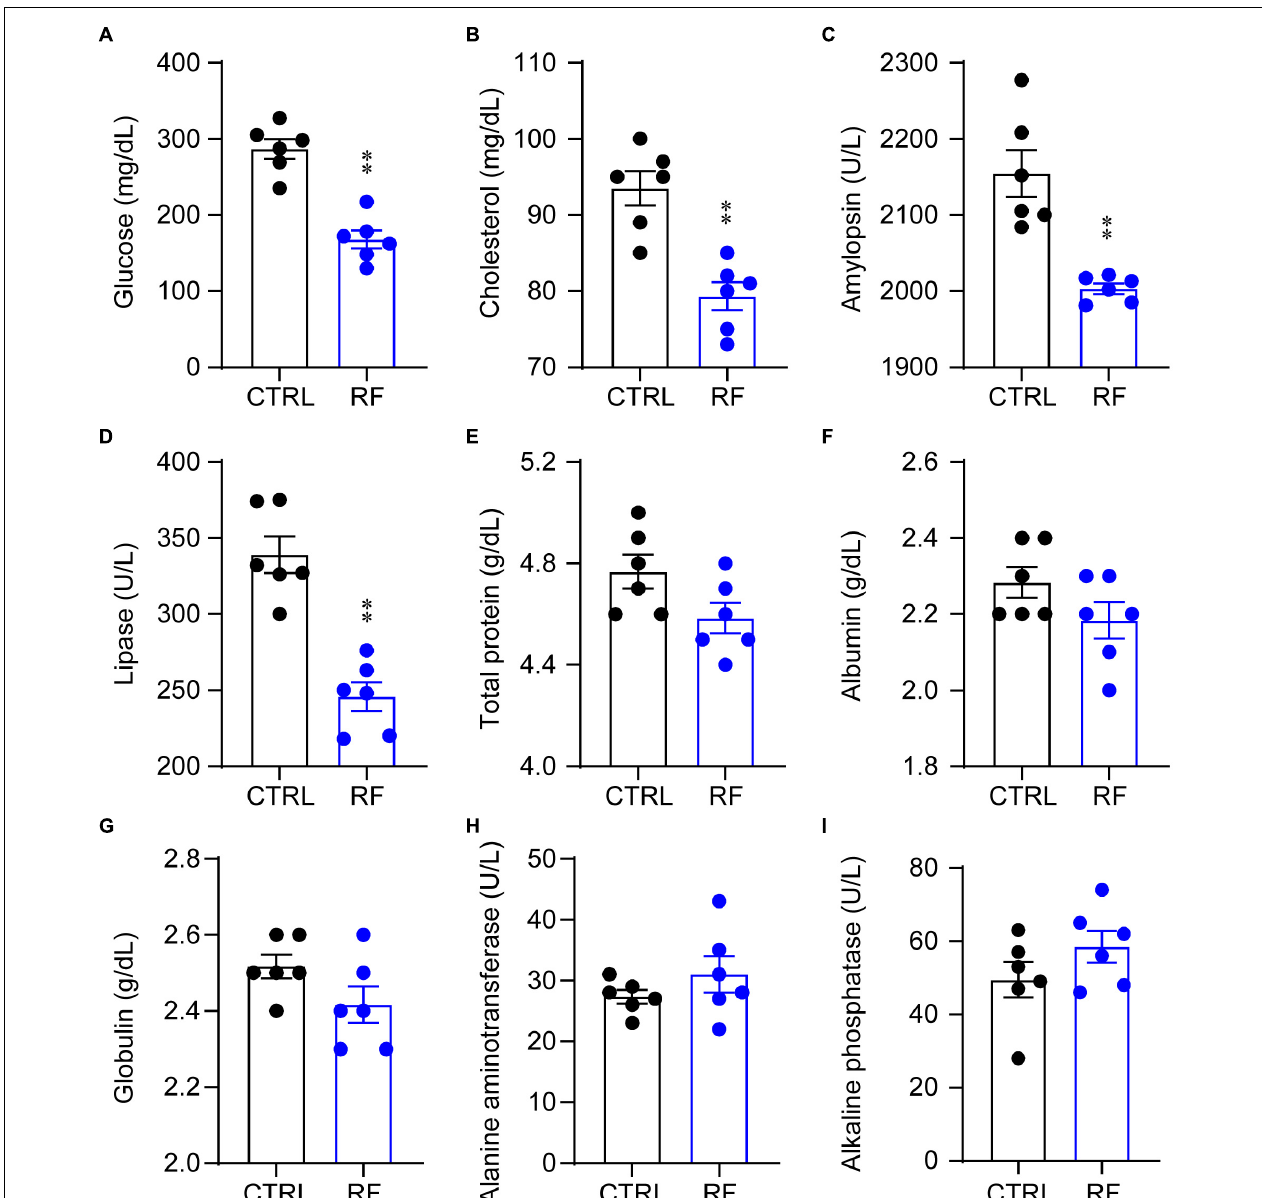
FIGURE 2 | Biochemical parameters in the RF and CTRL groups. Blood glucose (A) , cholesterol (B) , amylopsin (C) , lipase (D) , total protein (E) , albumin (F) , globulin (G) , alanine aminotransferase (H) , and alkaline phosphatase (I) . ∗∗ p < 0.01 versus CTRL, n = 6. CTRL, control; RF, restricted